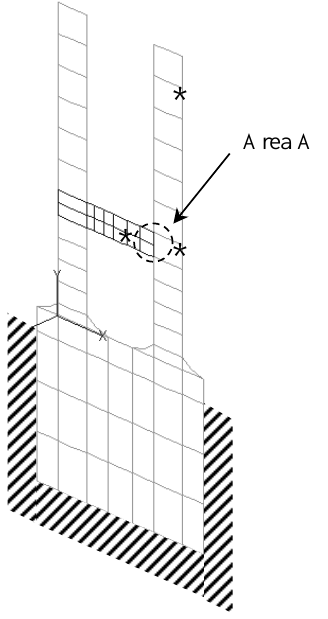
Fig. 7. FE Model of blade: ∗ Measurement